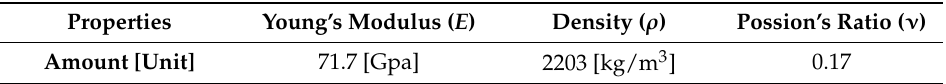
Table 1. The material properties of the imperfect hemispherical resonator model.